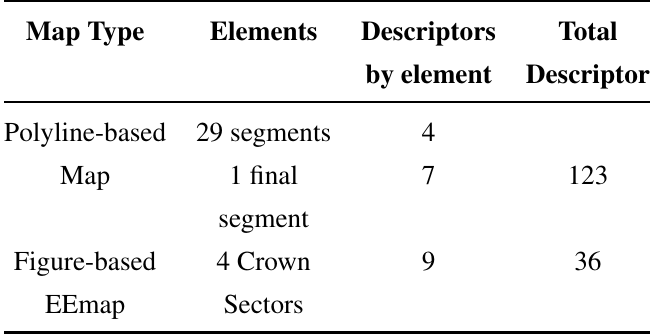
Table 5. Comparison of the number of parameters needed to describe the image shown in Figure 7(b) with a polyline-based map and our